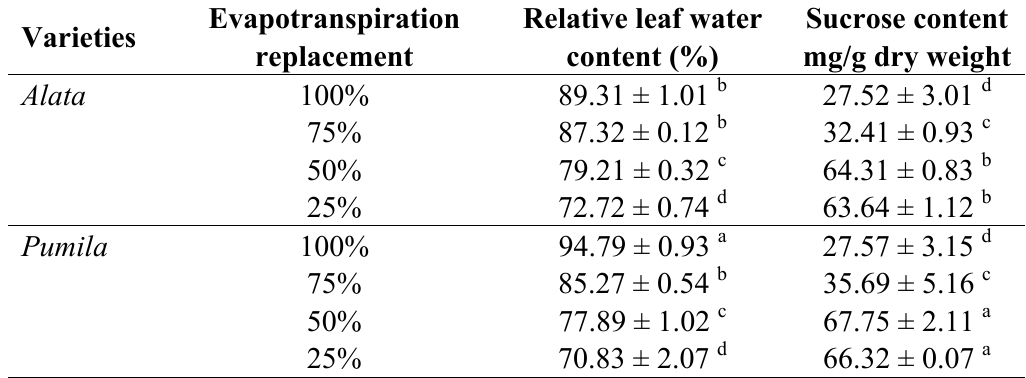
Table 4. Interaction effects between varieties and soil water capacity replacement on relative water content and sucrose